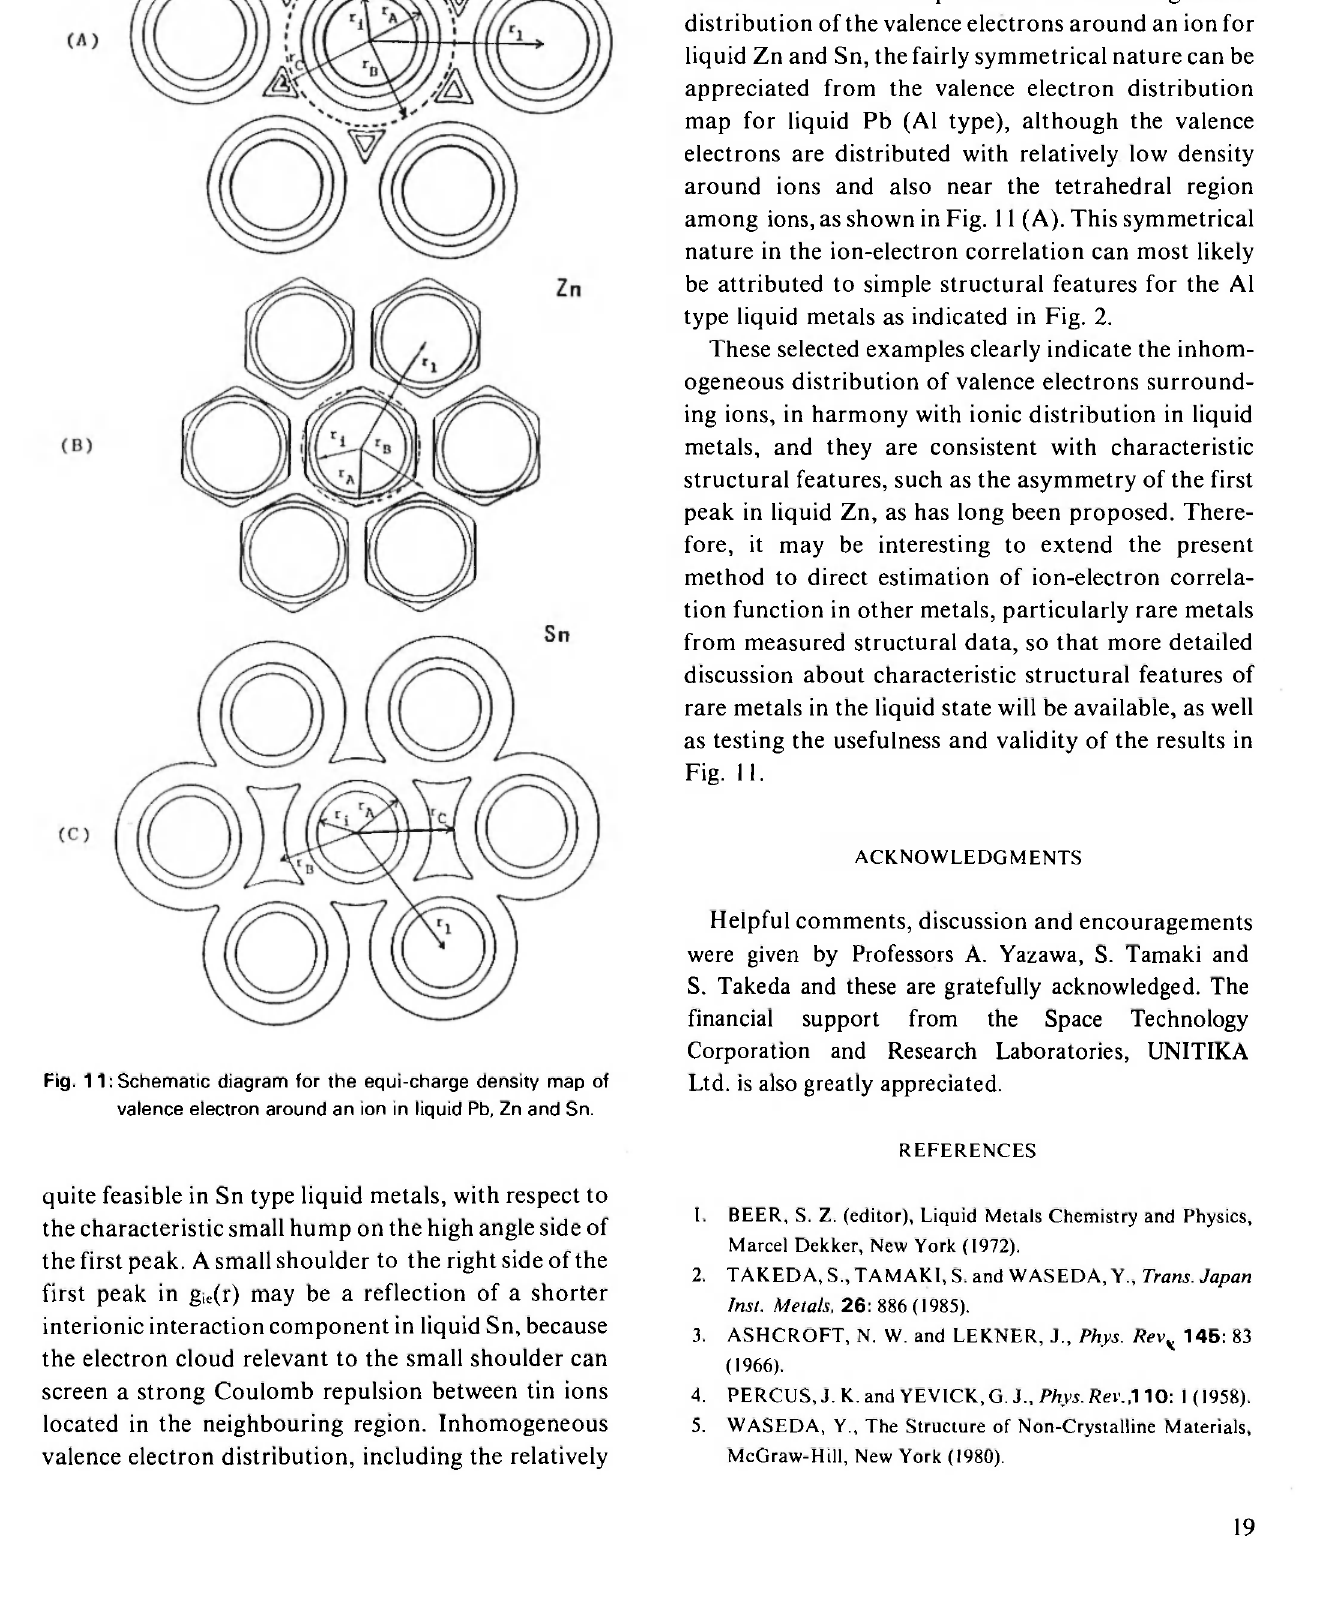
Fig. 11: Schematic diagram for the equi-charge density map of valence electron around an ion in liquid Pb, Zn and Sn.